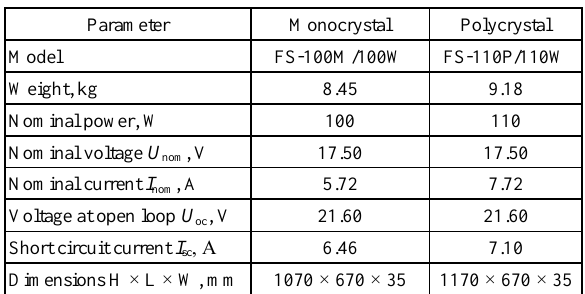
T ECHNICAL C HARACTERISTICS OF PV P